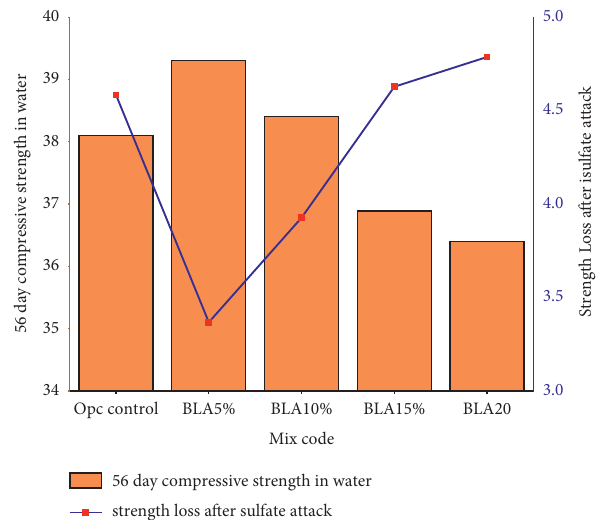
Figure 3: Strength loss due to sodium sulfate (Na